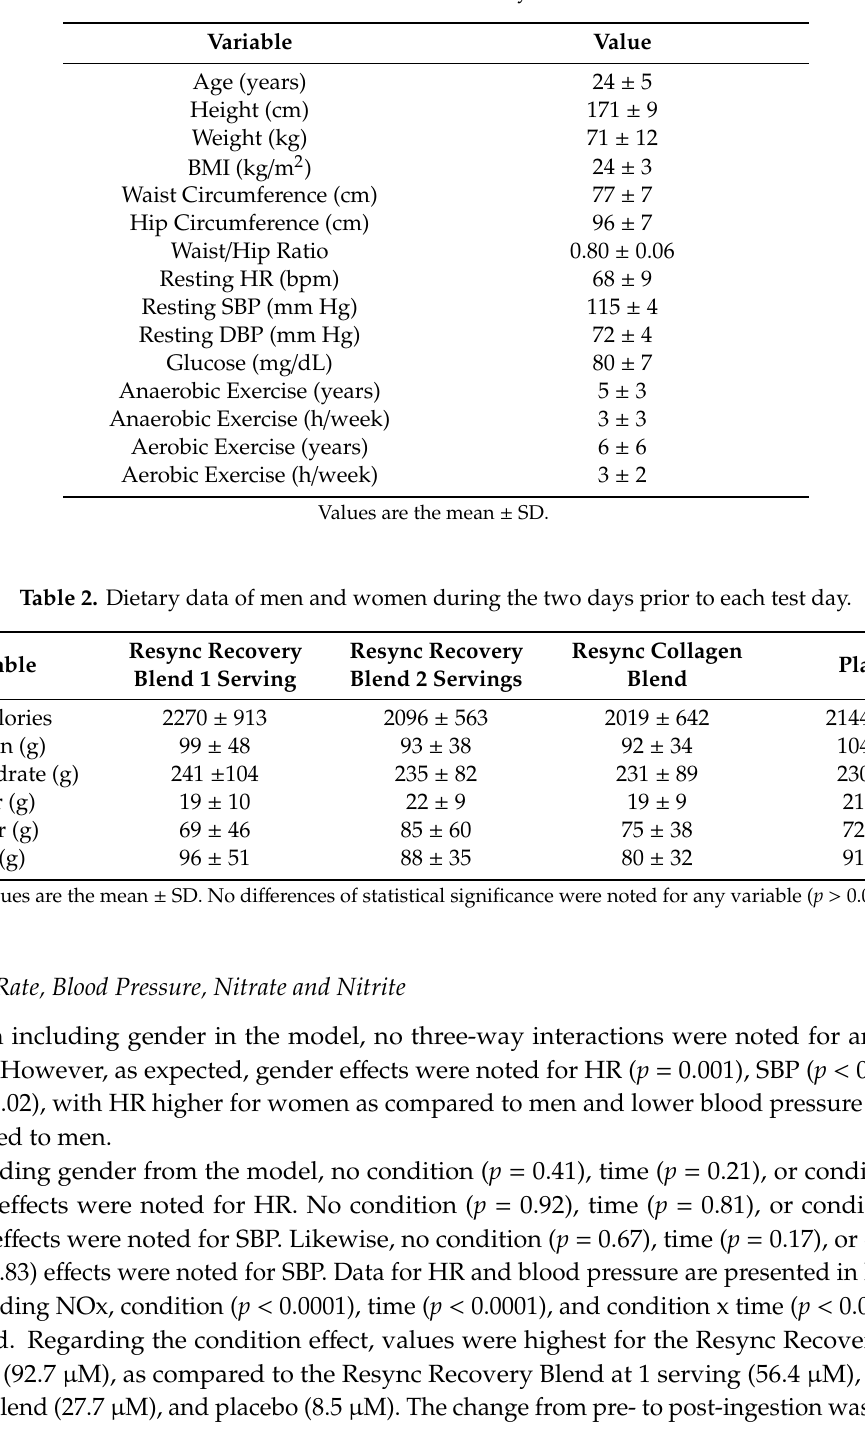
Table 1. Characteristics of 20 healthy men and women.